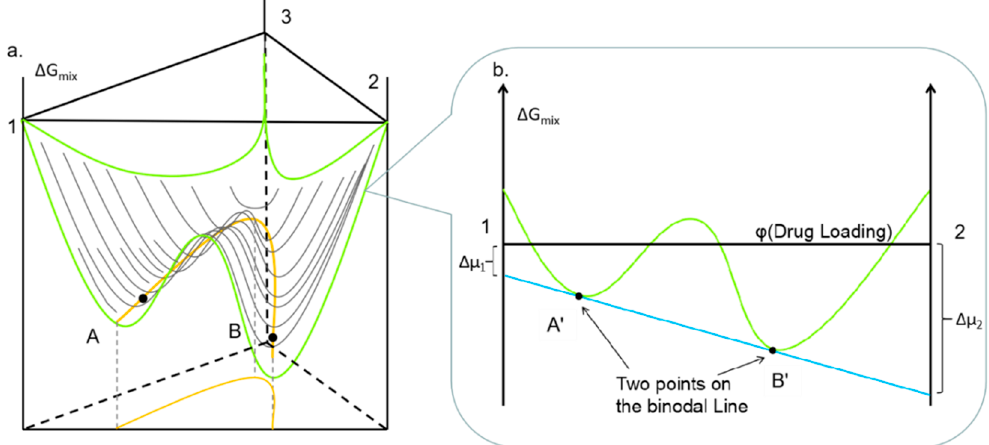
Figure 2. ( a ) Schematic diagram of Gibbs free energy surface (green line) of a ternary system at a constant temperature; the orange line representing the binodal curve (Figure 1) at constant temperature; ( b ) Illustration of Gibbs free energy profile for a binary system at a constant temperature using common tangent rule (blue line).